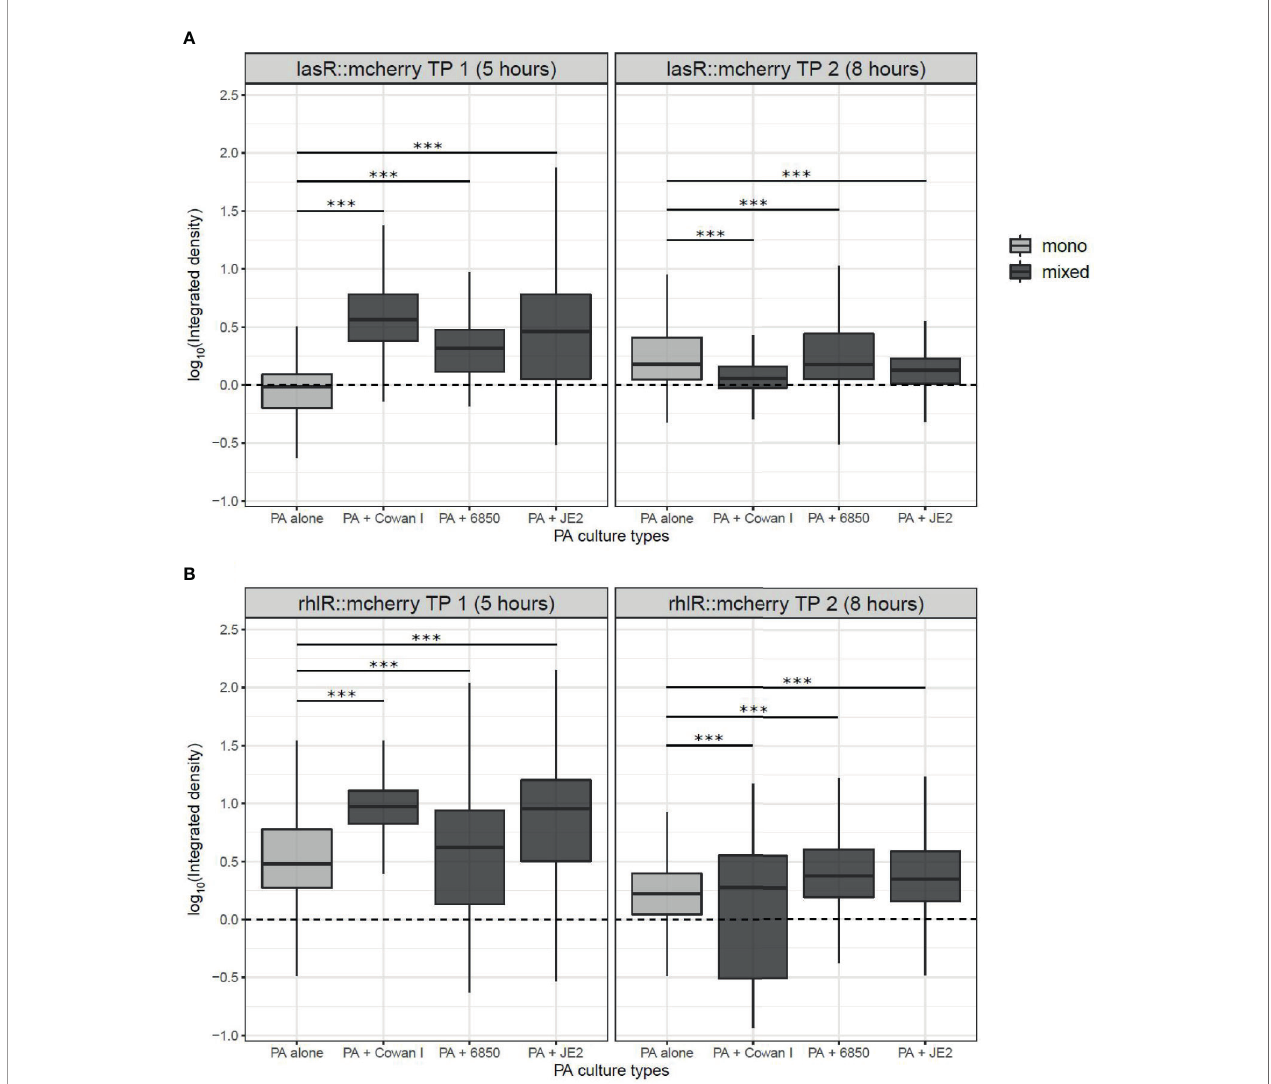
FIGURE 5 | Expression of quorum sensing (QS) regulator genes in P. aeruginosa (PA) in mono- and mixed cultures with S. aureus (SA) strains. We used PA strains harboring transcriptional double reporter strains, where the genes of the QS-regulators lasR or rhlR are fused to mCherry and the housekeeping gene rpsL is fused to GFP ( lasR::mcherry-rpsL::gfp and rhlR::mcherry-rpsL::gfp ). We inoculated these strains with (dark-grey) and without (light-grey) SA strains on agarose patches and took pictures of growing microcolonies at two timepoints, after fi ve hours (TP 1) and eight hours (TP 2) incubation at 37°C. (A) The expression of lasR is increased in mixed compared to monocultures of PA after fi ve hours, but evens out across treatments after eight hours. (B) The expression of rhlR is increased in mixed- compared to monocultures of PA after fi ve hours but evens out across treatments after eight hours. In comparison, the housekeeping gene rpsL is more homogeneously expressed across all treatments and time points ( Supplementary Figure S3; Table S2 ). The box plots show the median (bold line) with the fi rst and the third quartiles. The whiskers cover the 1.5* inter-quartile range (IQR) or extend from the lowest to the highest value if they fall within the 1.5* IQR. ***p < 0.001. Data is from three independent experiments. Supplementary Figures S4 and S5 show the expression of lasR , rhlR , and rpsL from both timepoints for each of the three independent experiments as density